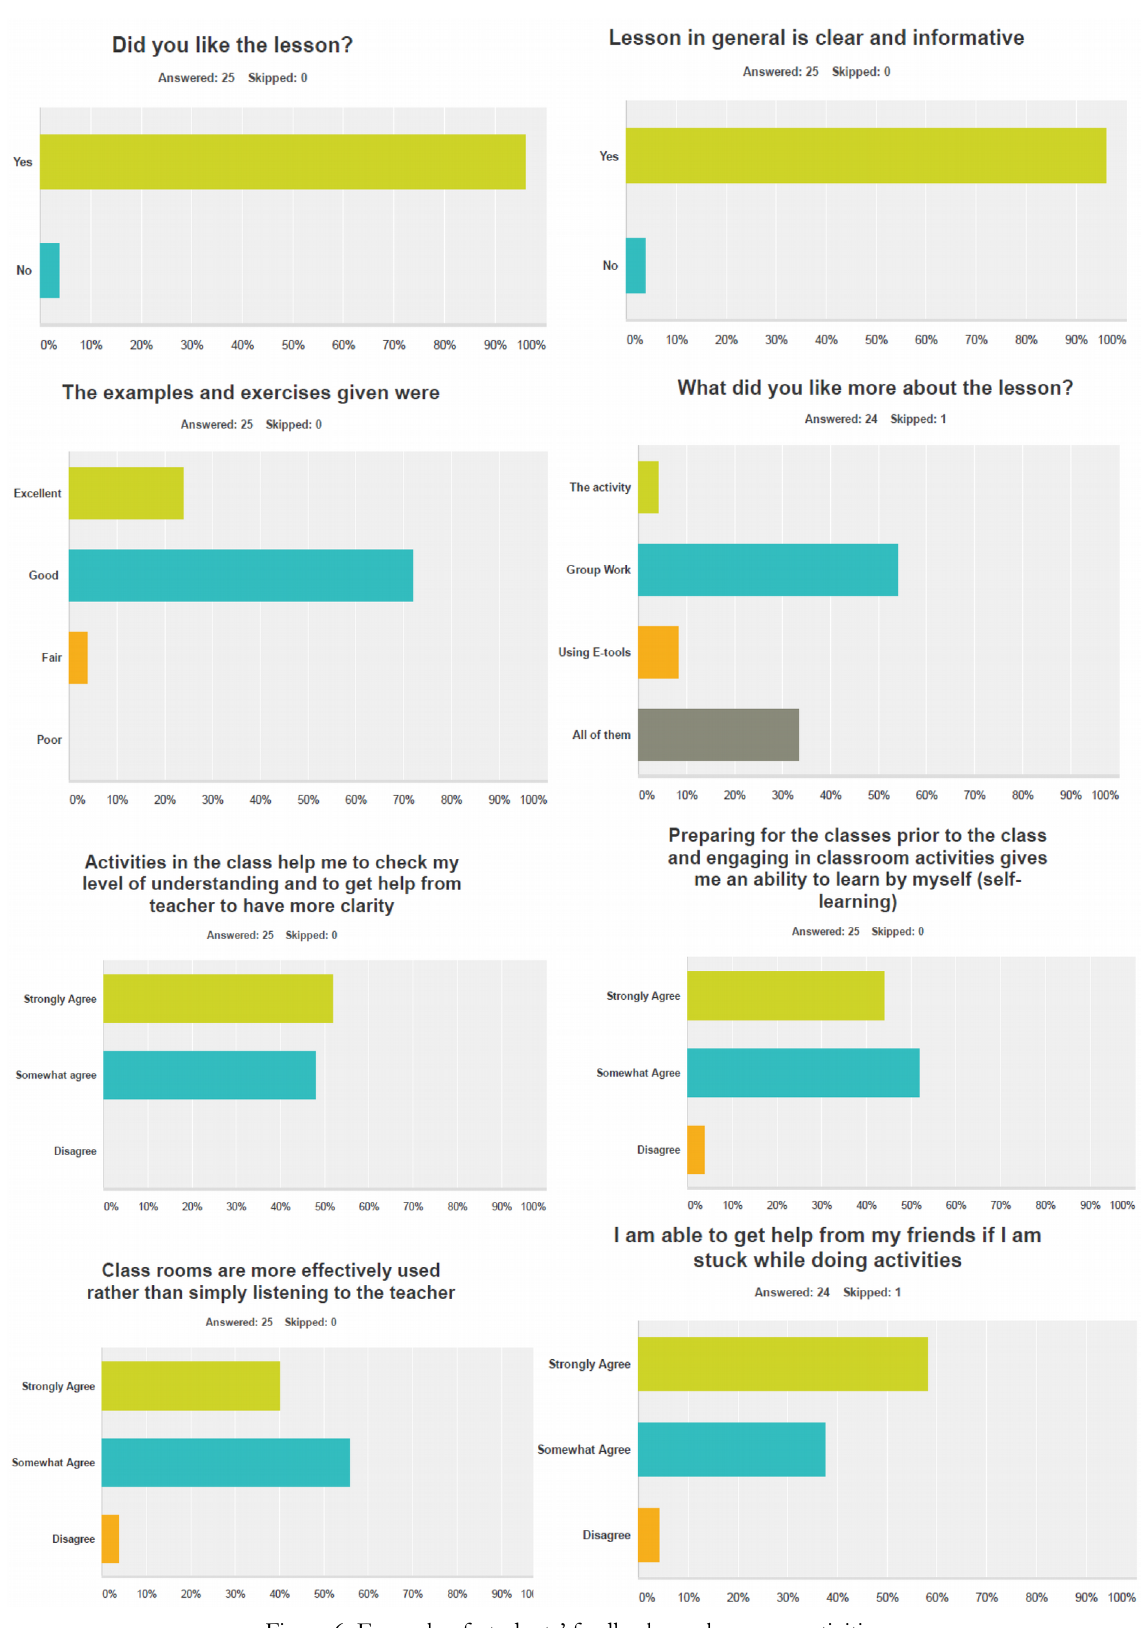
Figure 6. Example of students’ feedback on classroom